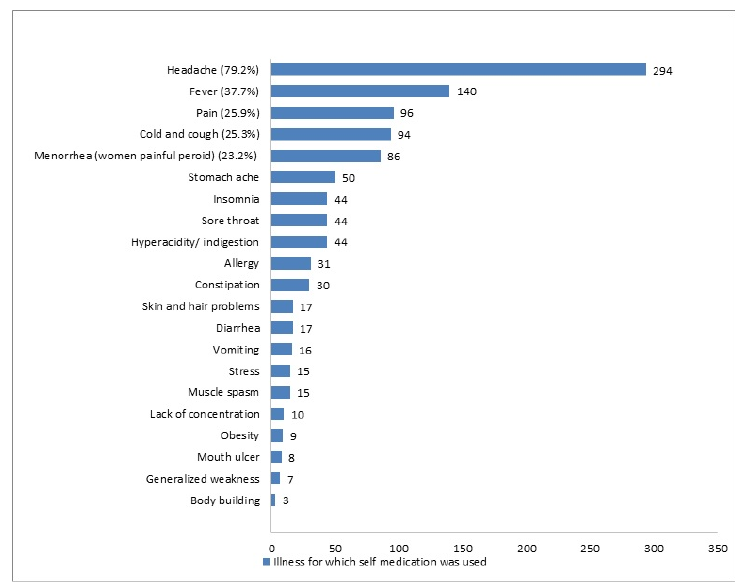
Figure 2. Illness for which SM was practiced during the last months .